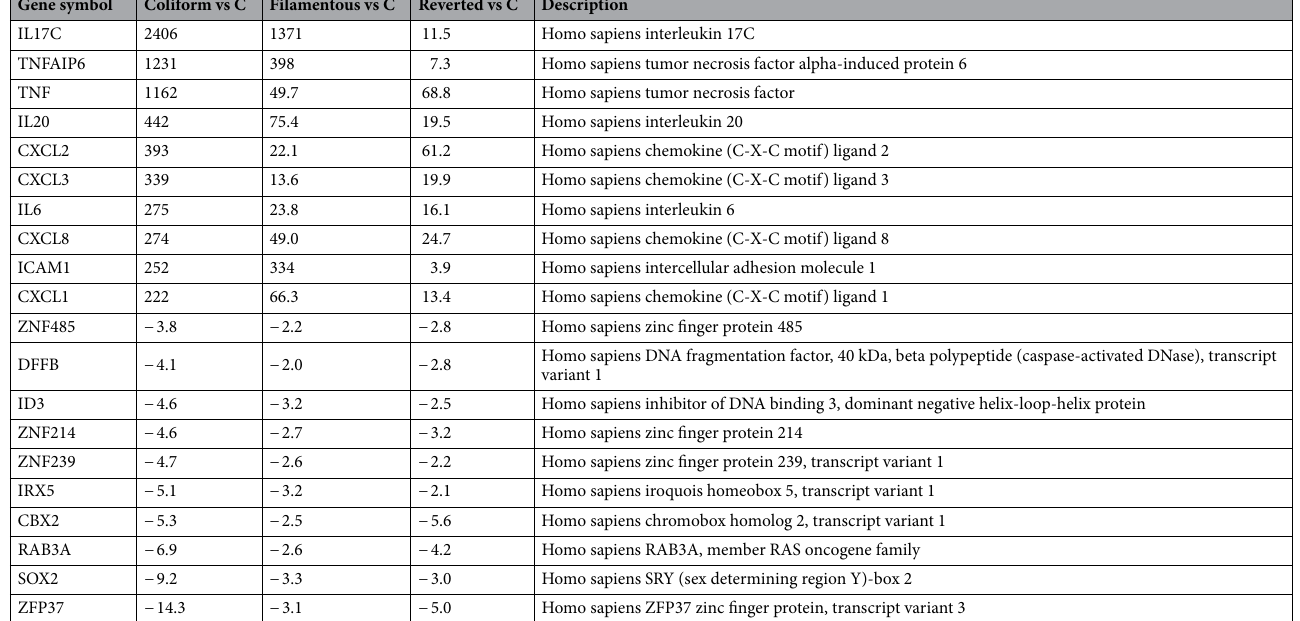
Table 2. A comparative analysis of shared gene entities altered in HBEP cells after stimulation with all three morphologies (Coliform, Filamentous, Reverted). Data are expressed as fold change compared to unstimulated control cells (C). The top 10 up-regulated and down-regulated genes are